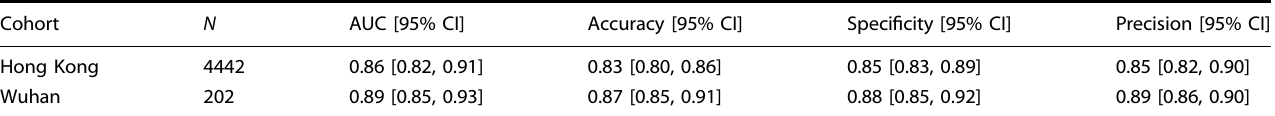
Table 9. Comparisons of different performance measures for the clinical risk score for the Hong Kong cohort ( fi vefold cross-validation) and the Wuhan cohort.